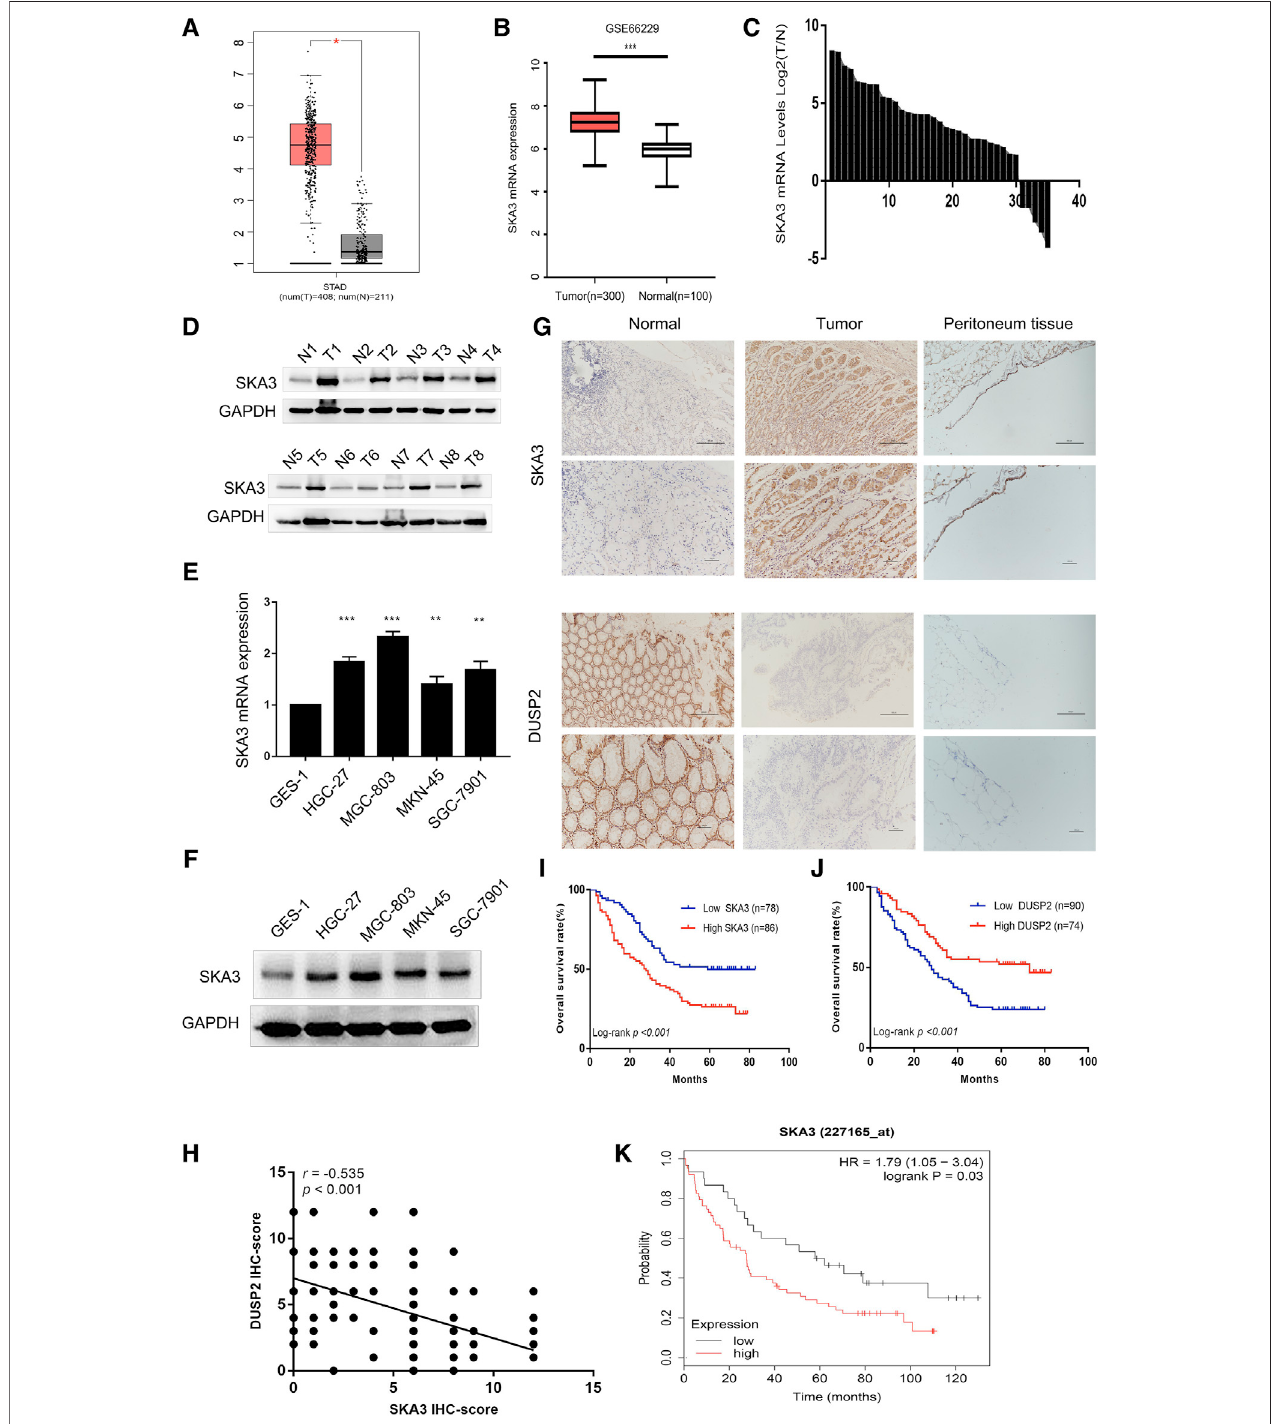
FIGURE1| SKA3isupregulatedingastriccancer. (A) SKA3mRNAexpressioninTCGAdatabase. (B) SKA3mRNAexpressioninGEOdatabase. (C) SKA3mRNA expressioningastriccancertissues. (D) SKA3proteinlevelsingastriccancertissues.N,normaltissue.T,tumortissue. (E) SKA3mRNAexpressioningastriccancercell lines. (F) SKA3 protein levels in gastric cancer cell lines. (G) SKA3 and DUSP2 expression in gastric cancer tissues, normal tissues, peritoneal tissues by immunohistochemistry (IHC). (H) The correlation between SKA3 and DUSP2 IHC score by scatter plots. (I) Kaplan-Meier survival curves about SKA3. (J) Kaplan- Meier survival curves about DUSP2. (K) The prognostic signi fi cance of SKA3 high and low expression in Kaplan-Meier plotter database.* p < 0.05, ** p < 0.01, *** p < 0.001.